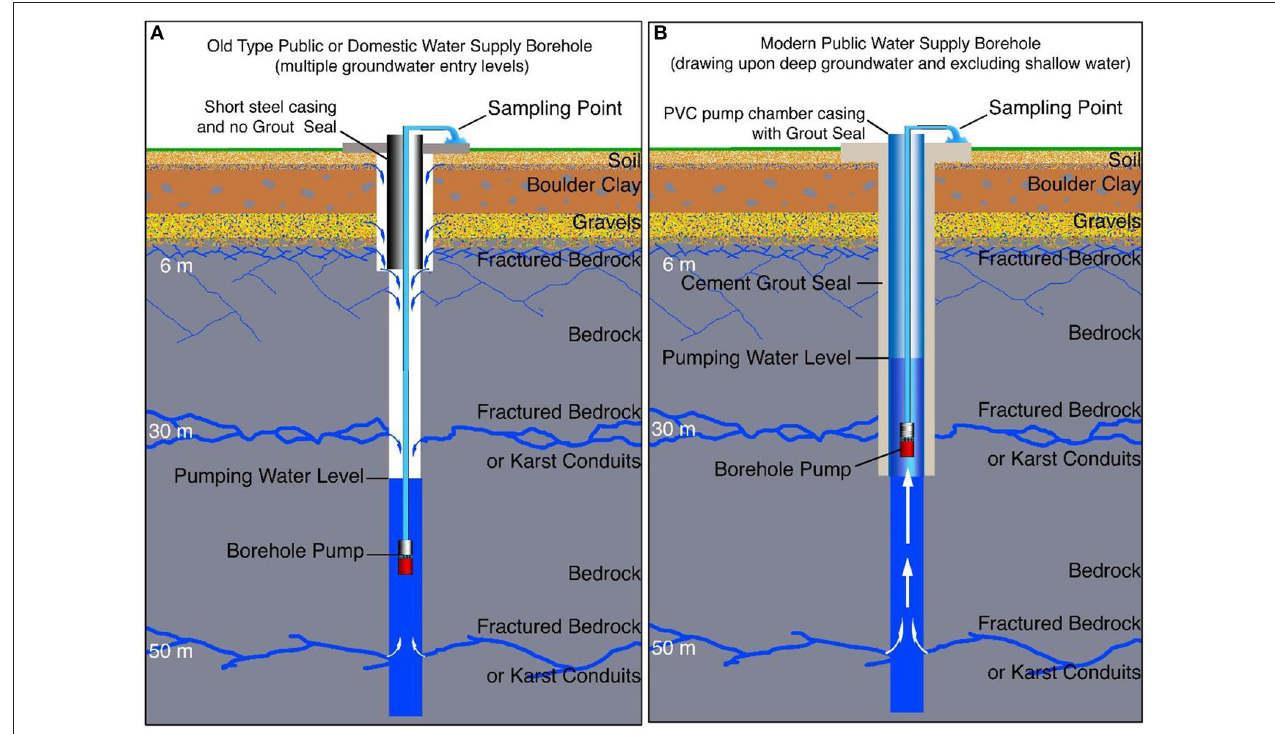
FIGURE 2 | Graphical representation of an (A) older and (B) more modern borehole construction. The pumps in older boreholes are often too powerful and set deep. These boreholes are usually pumped intensely for short periods. Groundwater cascades down the borehole from shallow levels to the pump. On the other hand more modern boreholes have pumps set within the pump chamber casing. The pumps are usually operated gently and continuously. The deep groundwater flows to the